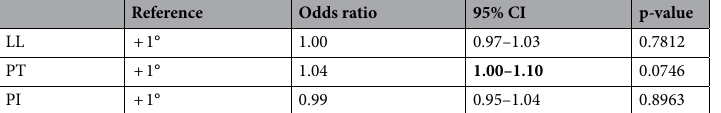
Table 4. Association of PGD with spino-pelvic parameters (multivariate analysis). Bold values indicate a positive association with PGD. Odds ratios are calculated by multiple logistic regression analysis after adjustment by age, sex and body mass index on 1481 participants. In creating the model, the propensity score for the objective variable is calculated from the adjusted variables and treated as one variable. PGD pistol